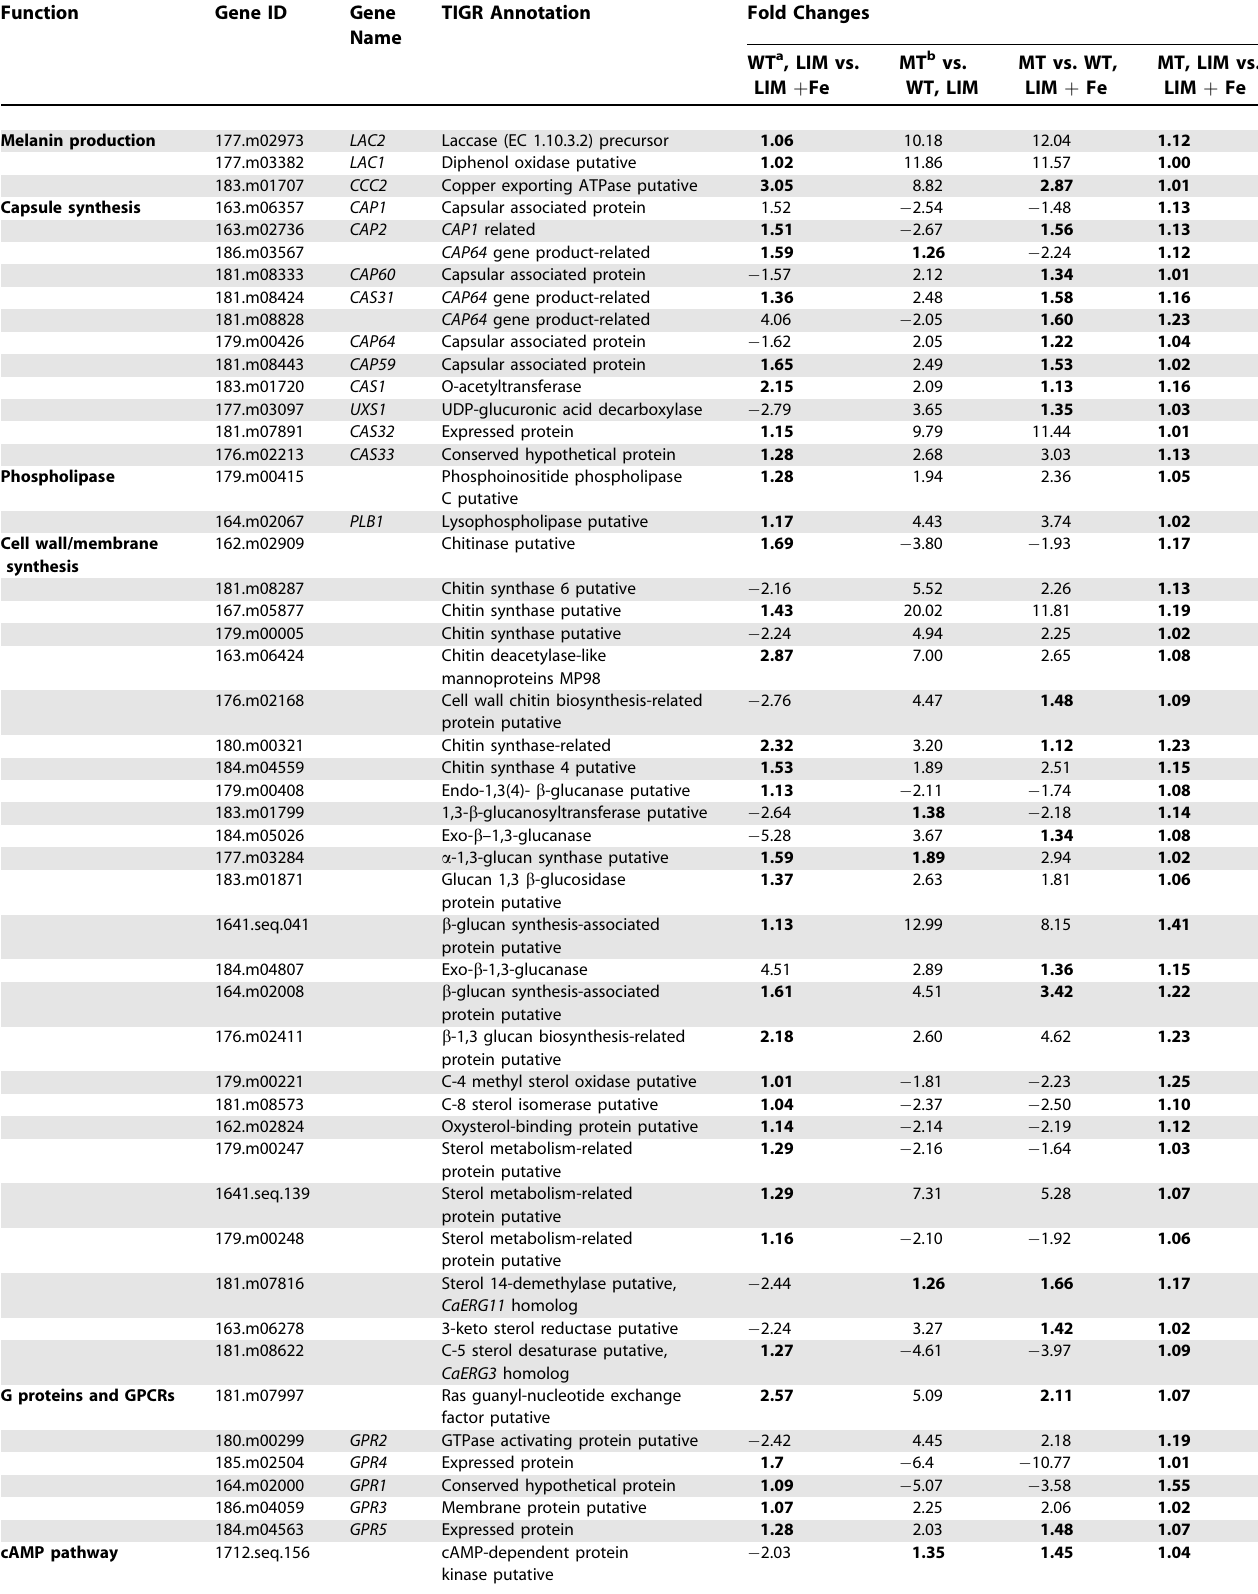
Table 3. List of Genes Differentially Expressed and Related to Virulence Factor Expression Function